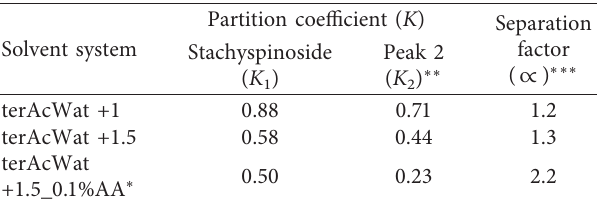
Table 1: Partition coefficients ( K ) and separation factor ( ∝ ) of stachyspinoside 1 in various solvent